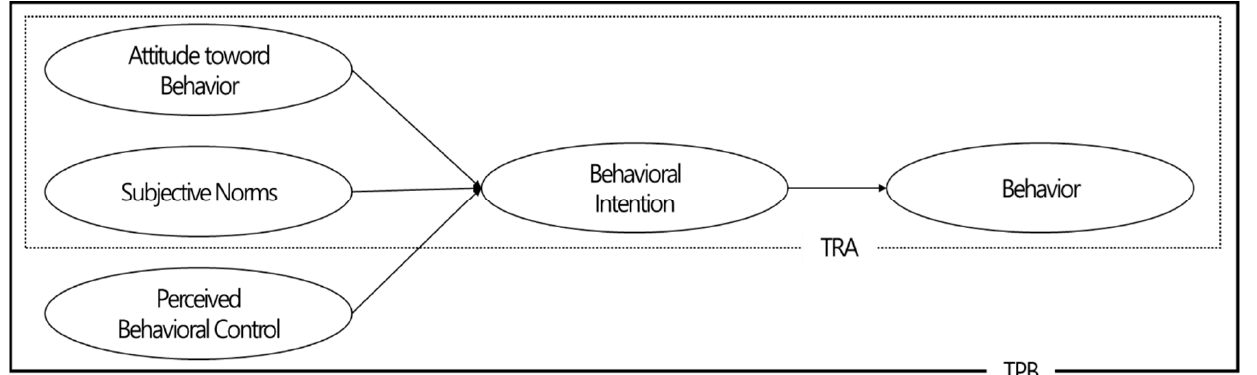
Figure 1. Theory of Reasoned Action (TRA) and Theory of Planned Behavior (TPB). Note: Theory of Reasoned Action (TRA), Theory of Planned Behavior (TPB). Source: Ajzen & Fishbein (1975). A Bayesian analysis of attribution processes; Ajzen (1988). Attitudes personality and behavior. Buckingham, UK: Open University Press.